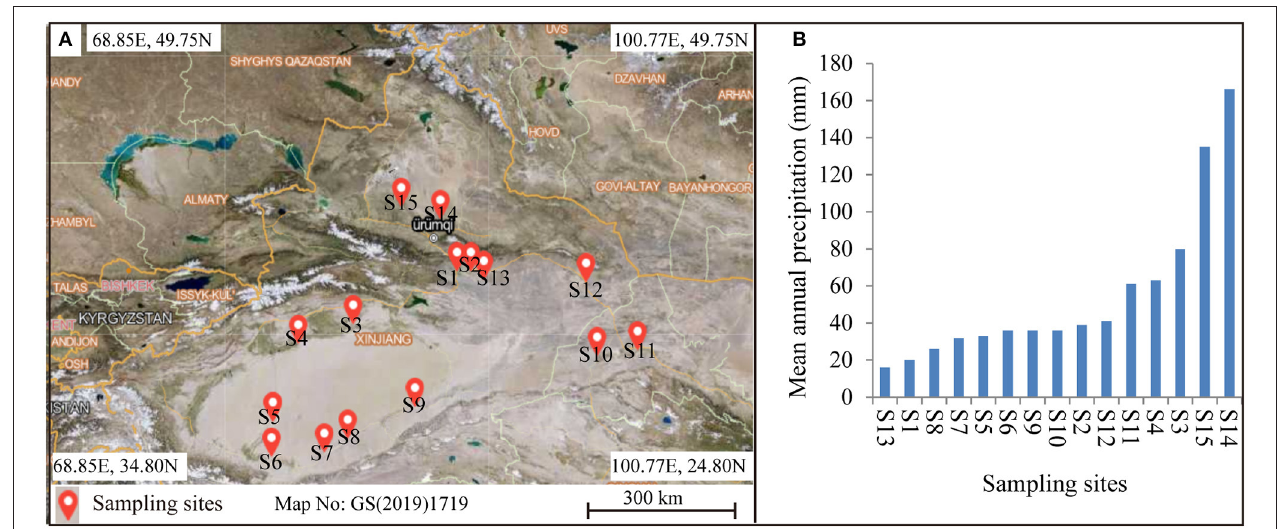
FIGURE 1 | (A) Geographical map showing the locations of the sampling sites used in this study, and (B) gradient in mean annual precipitation across the distribution of the sites.